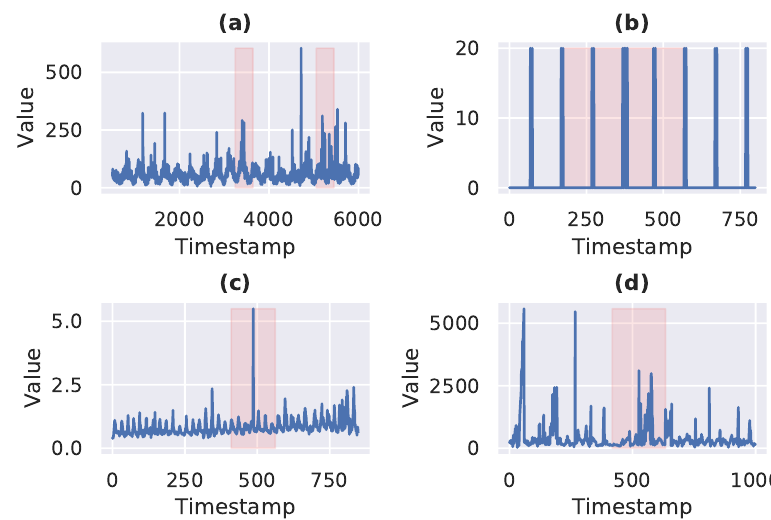
Figure 3. ( a )RealTweets(Twitter_volume_AMZN),( b )ArtificialWithAnomaly(art_increase_spike_density); ( c ) Real Ad Exchange (exchange-3_cpm_results); ( d ) Real Traffic (TravelTime_451_whole). Snippets of Numenta Anomaly Benchmark (NAB) time-series from different domains are plotted. Actual time-series are shown in blue, whereas the highlighted area shows an anomaly